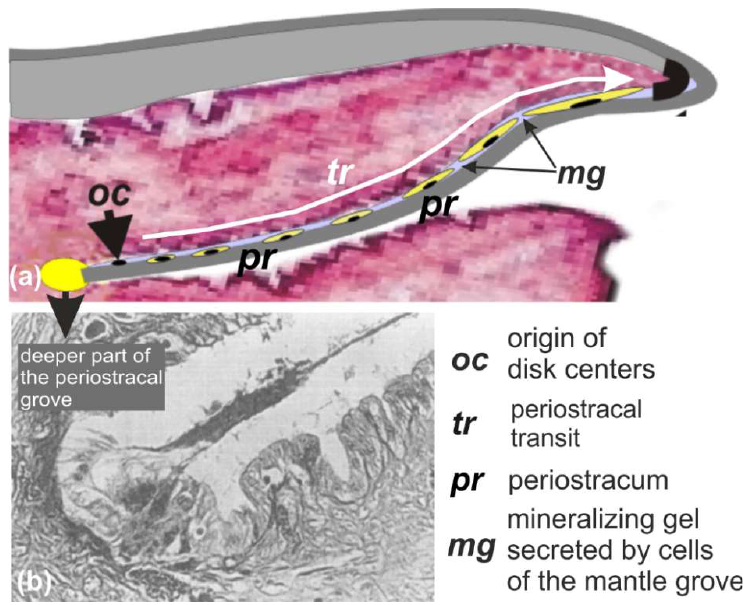
Figure A3. Scheme of the outer mantle grove ( a ) at growing edge of a Pinctada margaritifera shell cut perpendicular to shell surface. All along the animal life, periostracum is produced by a group of specialized cells ( b ). Through a pulsed secretion mode assessed by parallel striation (Figure 6c), the resulting membrane acts as a conveyor-belt for disks that grow by accretion of calcite rings around initial organic nodules deposited onto the internal side of the periostracal membrane. The black curved line shows the point where the disks are incorporated into the shell, becoming the fore-front of the solid shell. Credit pictures (a) Cuif and Dauphin, redrawn from Proceedings of the 14th Biomineralization meeting, Tsukuba, Japan, in press; b: [39].